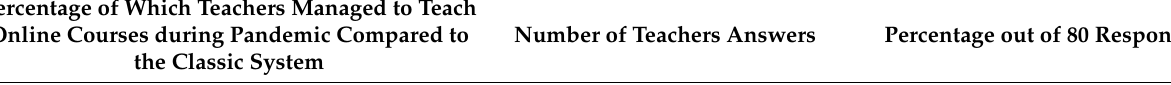
Table 7. Percentage of which teachers managed to teach online courses during COVID-19 compared to the classic system, prior to COVID-19 (question